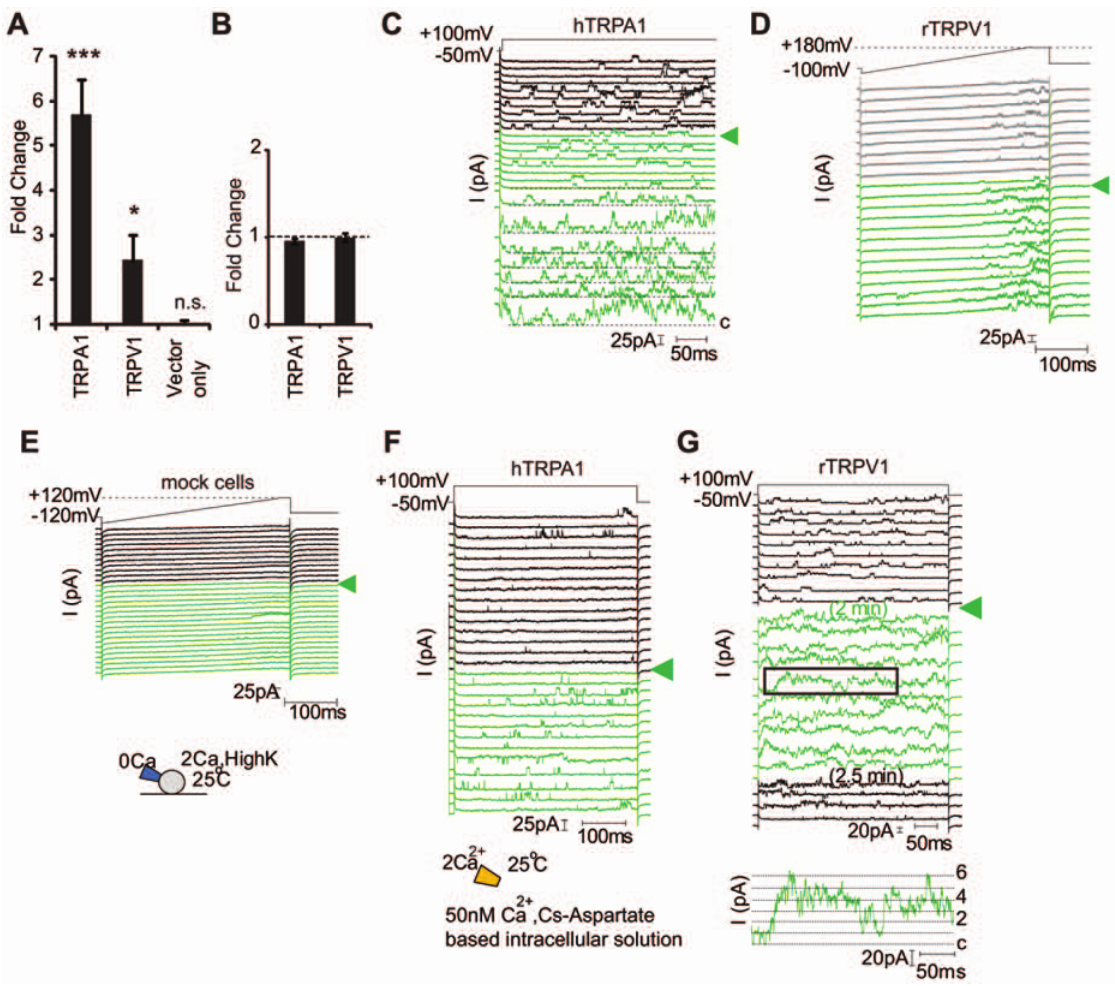
Figure 3. NO donor directly activates TRPV1 and TRPA1. SNAP (3 mM) increases TRP channel activity in cell-attached (A–E) and excised inside out patches (F, G). (A, B) The average fold change induced by SNAP (3 mM) (A) or by the inactive congener NAP (3 mM) (B) in cell-attached patches expressing TRPA1 (n=11 for (A), n=4 for (B)), rTRPV1 (n=4 for (A), n=3 for (B)) and endogenous channels from YFP-positive vector transfected cells (‘‘Vector only’’; n=3) is shown. Quantification of SNAP induced currents involved taking the difference between the averaged current obtained at a single voltage for all traces before and during SNAP application and the basal current level determined by averaging blank sweeps containing no TRP activity) during these same periods. The fold increase in current induced by SNAP is the leak subtracted SNAP-induced current normalized to the leak subtracted control current prior to SNAP addition (see Materials and Methods for more detail). (C) A cell-attached patch containing at least five hTRPA1 channels was challenged with a step depolarization from the resting membrane potential (near 0 mV) (V pipette from + 50 to 2 100 mV). Cell was exposed to SNAP (3 mM) beginning at the arrow (green traces);latency was 40 sec. (D) A cell-attached patch containing at least three rTRPV1 channels was challenged with a voltage ramp from 2 120 to + 180 mV (V pipette from + 120 to 2 180 mV) over 300 msec to visualize voltage-gated channel activity. Cell was exposed to NAP (3 mM, grey sweeps) initially and then SNAP (3 mM, green) at the time indicated by the green arrow. (E) A YFP-positive HEK293T cell expressing vector was challenged. No TRP-like SNAP-induced channel activity was observed over 2 min. Cartoon of experimental protocol is shown. (F, G) SNAP (3 mM) activated hTRPA1 (F) and rTRPV1 (G) in excised inside out patches. Cartoon of experimental protocol is shown. The inset in (G) shows currents in the boxed area at higher gain to indicate that the activity is consistent with the gating of at